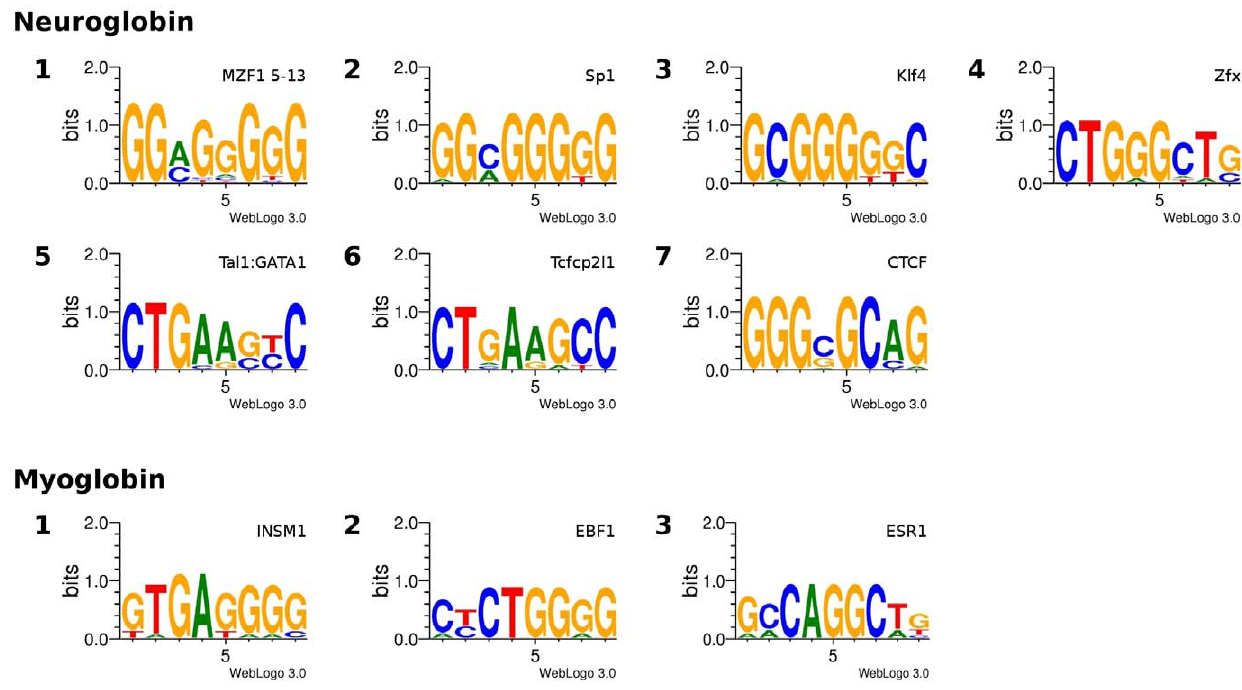
Figure 8. Results of the FootPrinter motif search. Sequence logos of found motifs in Mb and Ngb genes are shown. The found motifs are G-rich and highly conserved. According to the comparison against the JASPAR database the motifs show the highest similarity to binding sites of TFs highlighted above the logos. The results of the complete phylogenetic footprinting analyses are summarized in Table1.